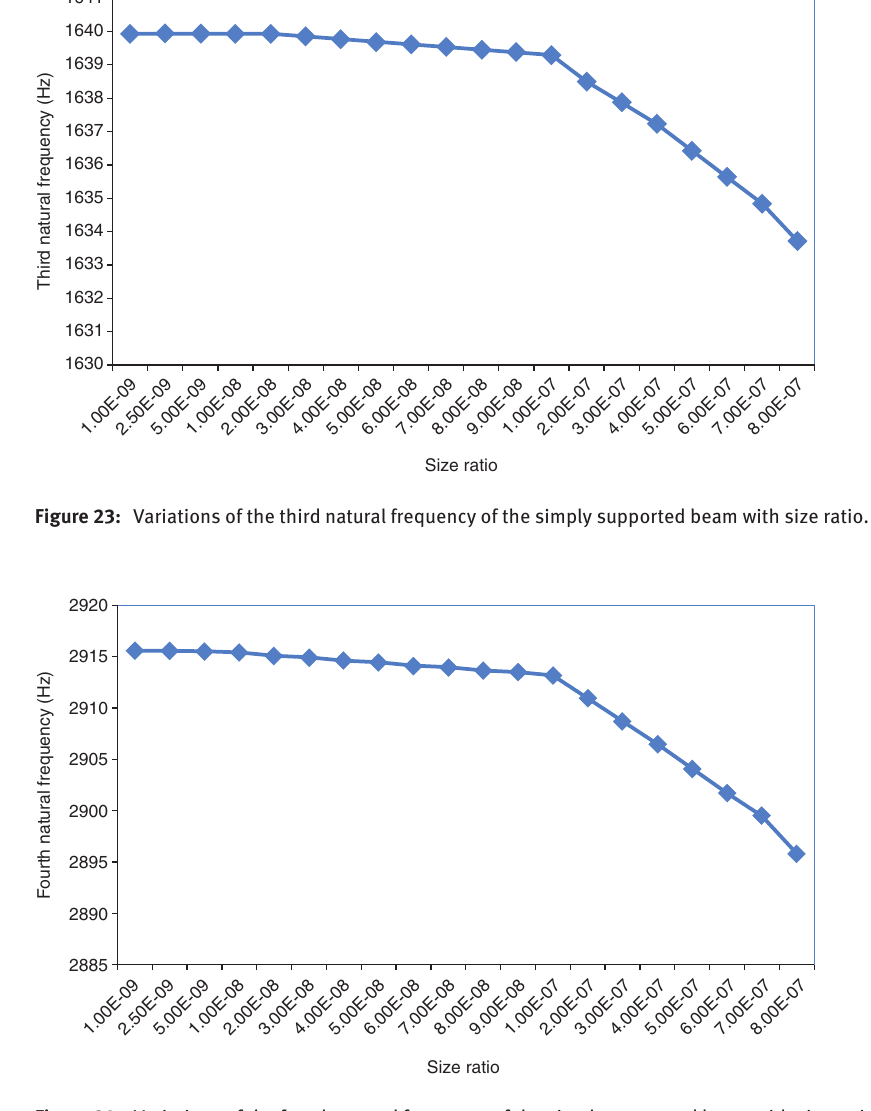
Figure 24: Variations of the fourth natural frequency of the simply supported beam with size